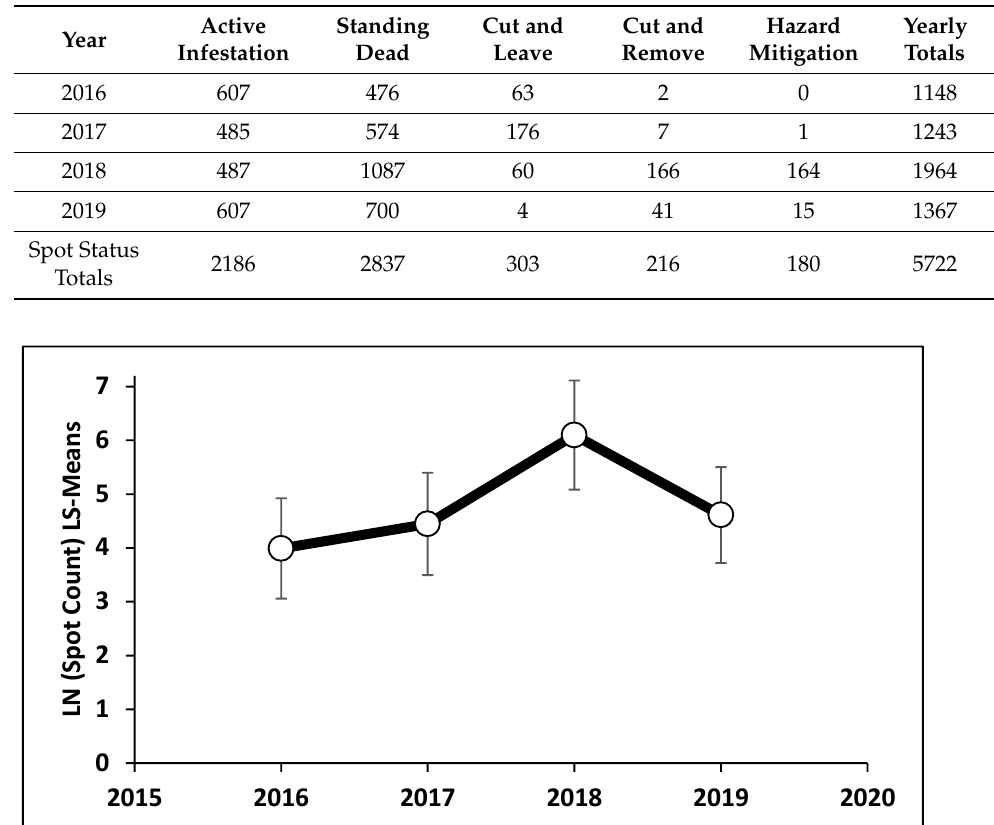
Table 1. Contingency table describing southern pine beetle spots on a year (row) by status (column) basis.